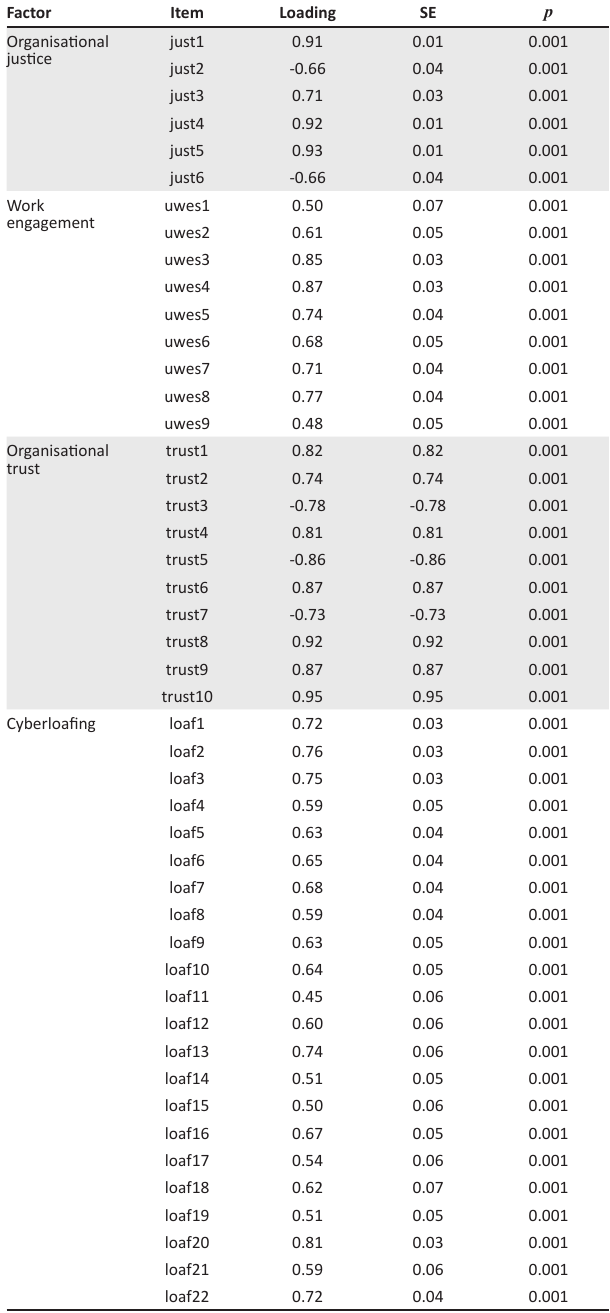
TABLE 2: Factor loadings for the latent